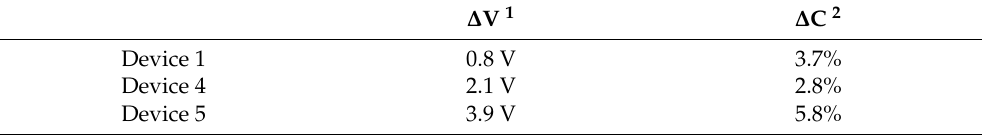
Table 6. Peak voltage and peak capacitance shift values after degradation of devices 1, 4, and